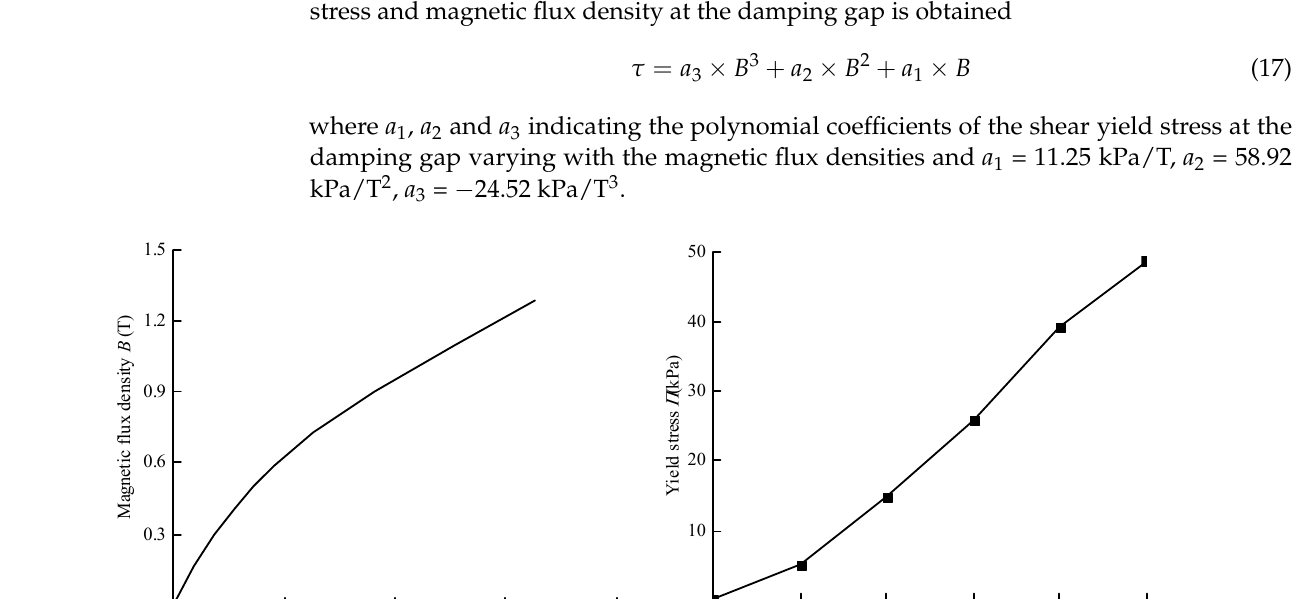
( b ) Figure 6. Comparison of the magnetic flux lines: ( a ) Proposed MR damper; ( b ) Traditional MR damper. Figure 7 shows the contours of magnetic flux density of the both MR damper at the current of 1.5 A. More than half of the flow path of the traditional MR damper is absent in the magnetic field. However, the inner, middle gaps and majority of outer gaps in Figure 7a are all exposed to the magnetic field. The magnetic flux density of the inner gaps is approximately 0.5 T. The maximum magnetic flux density of the proposed MR damper, which is at the magnetic core, is 1.4 T, while the larger value of 1.8 T is observed in the traditional one, which is close to the magnetic saturation of the magnetic material. The latter has lower magnetic resistance, leading to premature magnetic saturation that can be relatively avoided in the former, that is, the proposed MR damper could achieve a high utilization rate of the magnetic field.